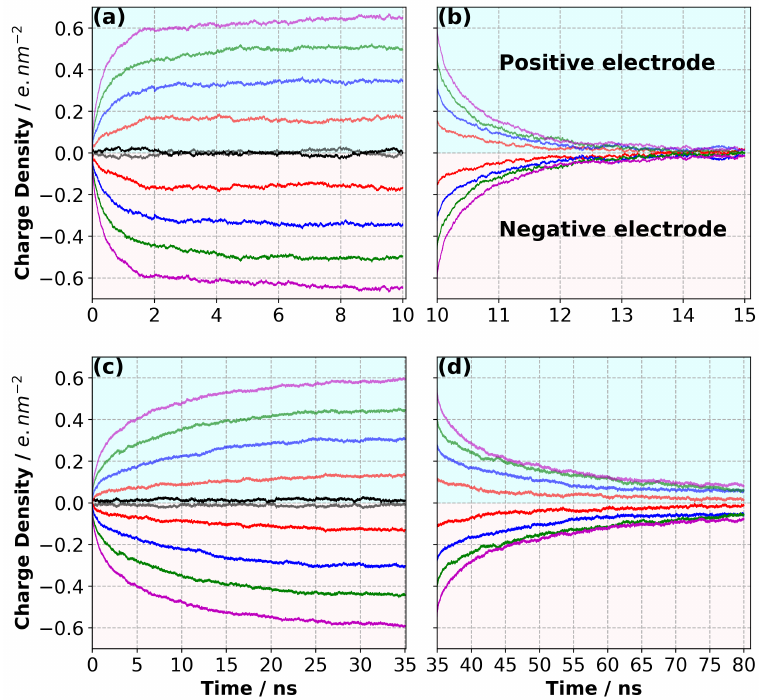
Figure 4. Evolution of the charge density on the electrodes during ( a ) charging with [C 2 mim][NTf 2 ], ( b ) discharging with [C 2 mim][NTf 2 ], ( c ) charging with [N 4,1,1,1 ][NTf 2 ] and ( d ) discharging with [N 4,1,1,1 ][NTf 2 ]. The results calculated with different potential differences are shown as a function of the simulation time. Colour scheme: black, red, blue, green and magenta for ∆Ψ = 0 V, 1 V, 2 V, 3 V and 4 V,